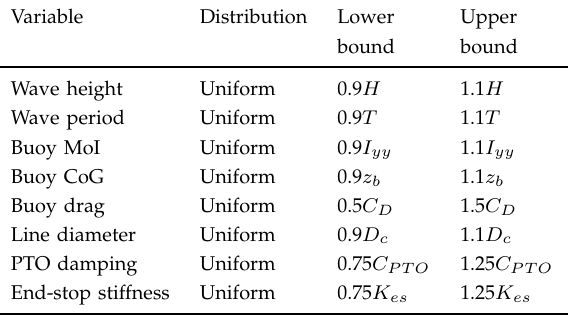
TABLE III R ANDOM INPUT VARIABLES , DISTRIBUTIONS AND RANGES .